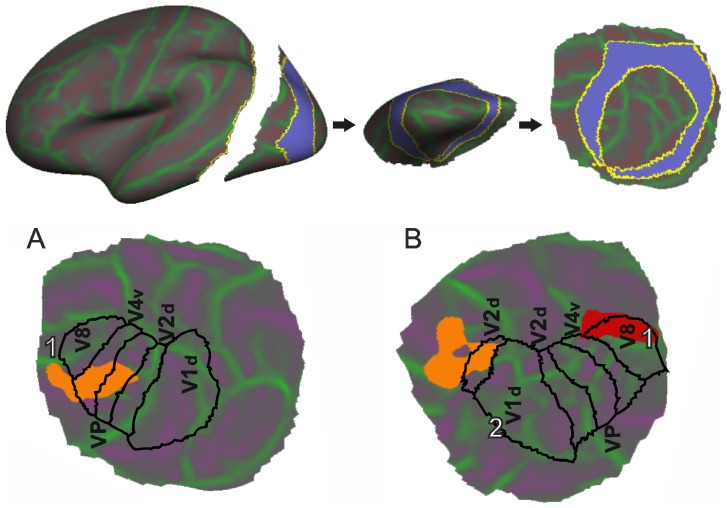
Localization of thinned areas on the visuotopic cortical atlas for left (A) and right (B) hemispheres.Coloured blobs correspond to clusters with statistically significant differences in cortical thickness. A black line corresponds to PALAIS_B12.Visuotopic areas related to the study. White numbers correspond to clusters surviving the p<0.001 level multiple comparison correction procedure (see Table 2 and 3 for coordinate and cluster size information).